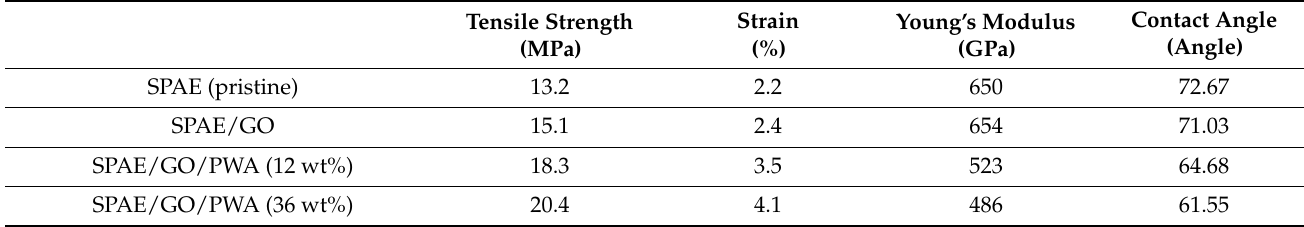
Table 1. Mechanical properties of SPAE/PWA composite membranes: tensile strength, strain, Young’s modulus, contact